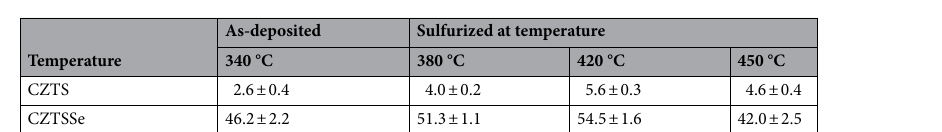
Figure 2. Characterization of the as deposited and sulfurized CZTS films using XRD and Raman spectroscopy. XRD pattern of CZTS absorbers: as-deposited (340 °C) and after sulfurization at temperatures of 380, 420 and 450 °C. The characteristic diffraction peaks of CZTS phase are marked with the circle, while the asterix marks the XRD patterns corresponding to FTO substrate (SnO 2 (ICDD # 04-003-0974)) (Fig. 2a). Raman spectra of the as-deposited CZTS films (340 °C) and CZTS films sulfurized at various temperatures of 380, 420 and 450 °C in the spectral range of 150–470 cm −1 (Fig. 2b).